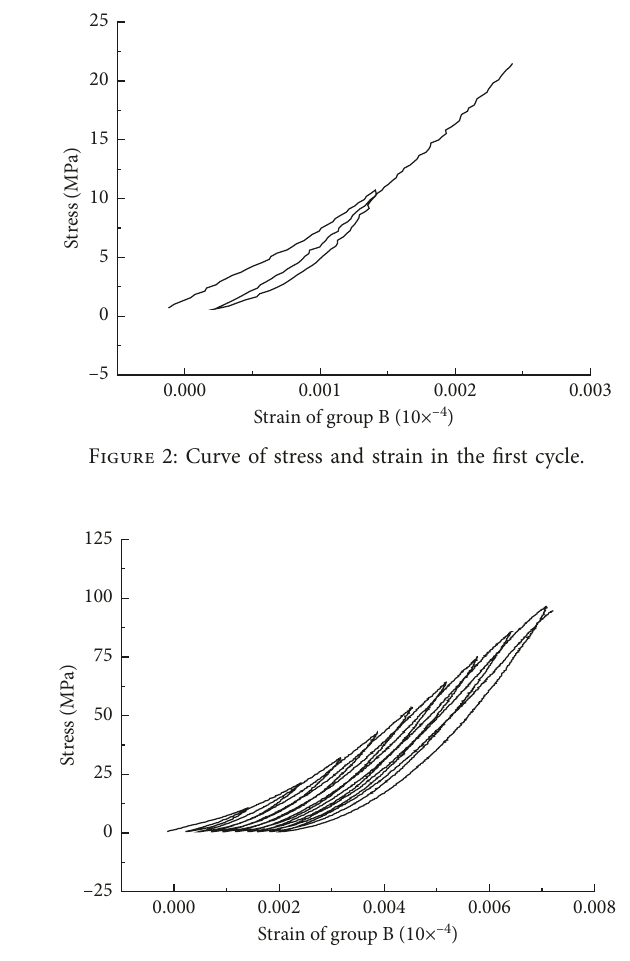
Figure 3: Curve of stress and strain of cycle loading and